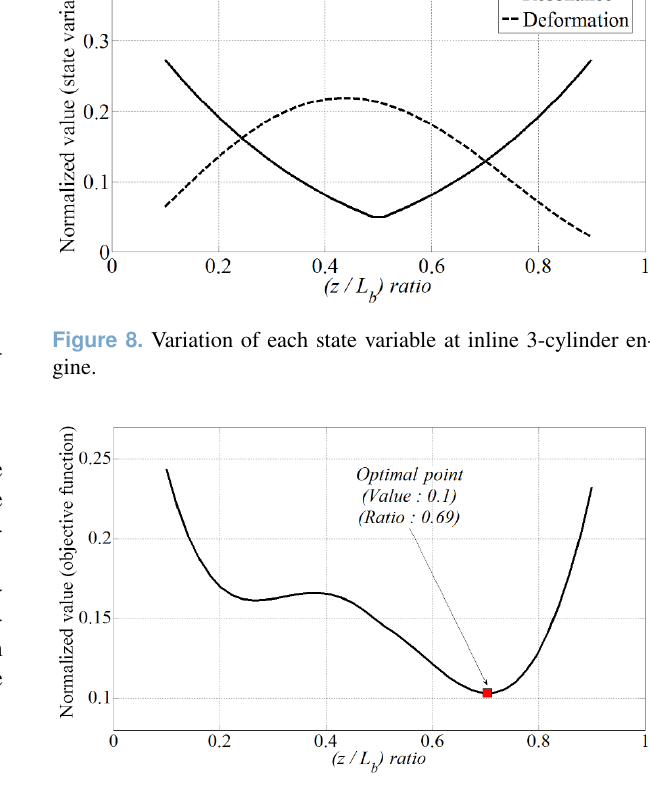
Figure 9. Variation of objective function at inline 3-cylinder en-